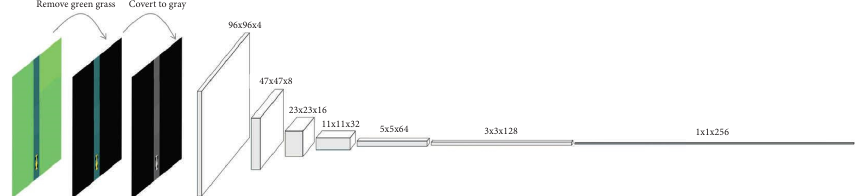
Figure 7: Neural network architecture used in training from image color handling to neural network design.